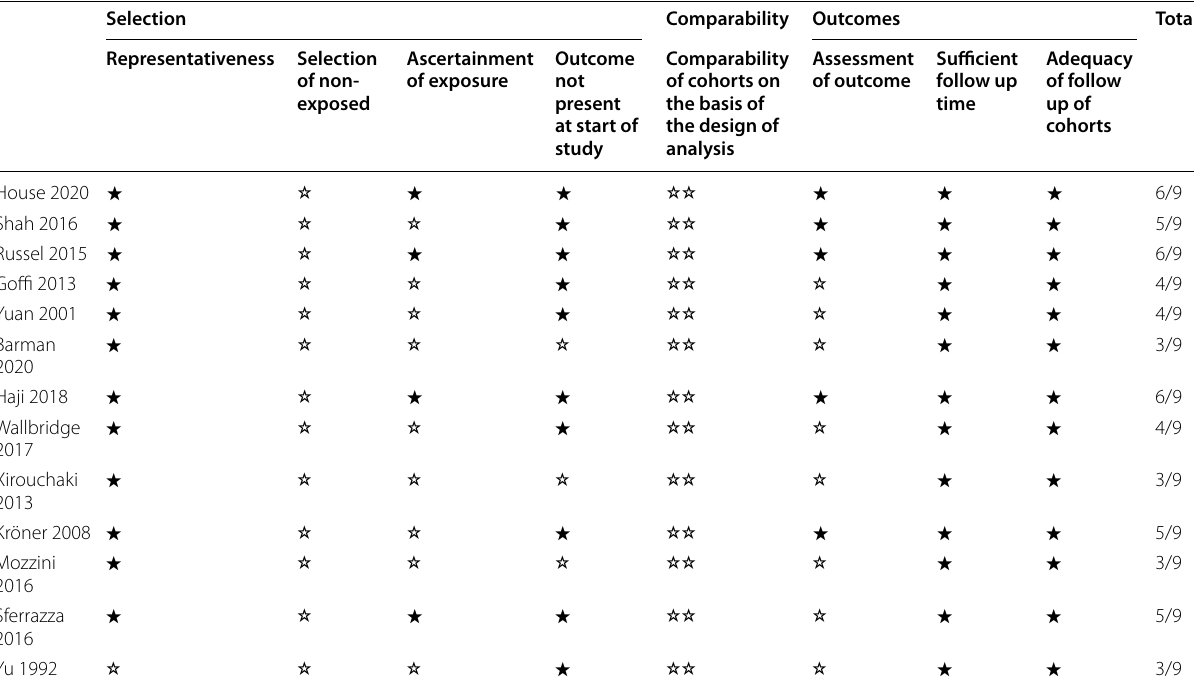
Empty stars reflects lack of sufficient quality on the respective domains. Full starts reflect sufficient quality on respective domains where total represents high (0–3 stars), moderate (4–6 stars), or low (7–9 stars) risk of bias